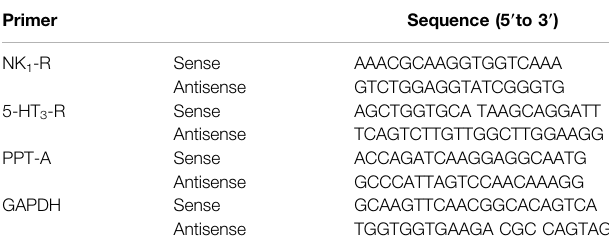
TABLE 1 | List of primers (and the respective sequences) used for RT-PCR analysis in this study. Primer Sequence (5 9 to 3 9